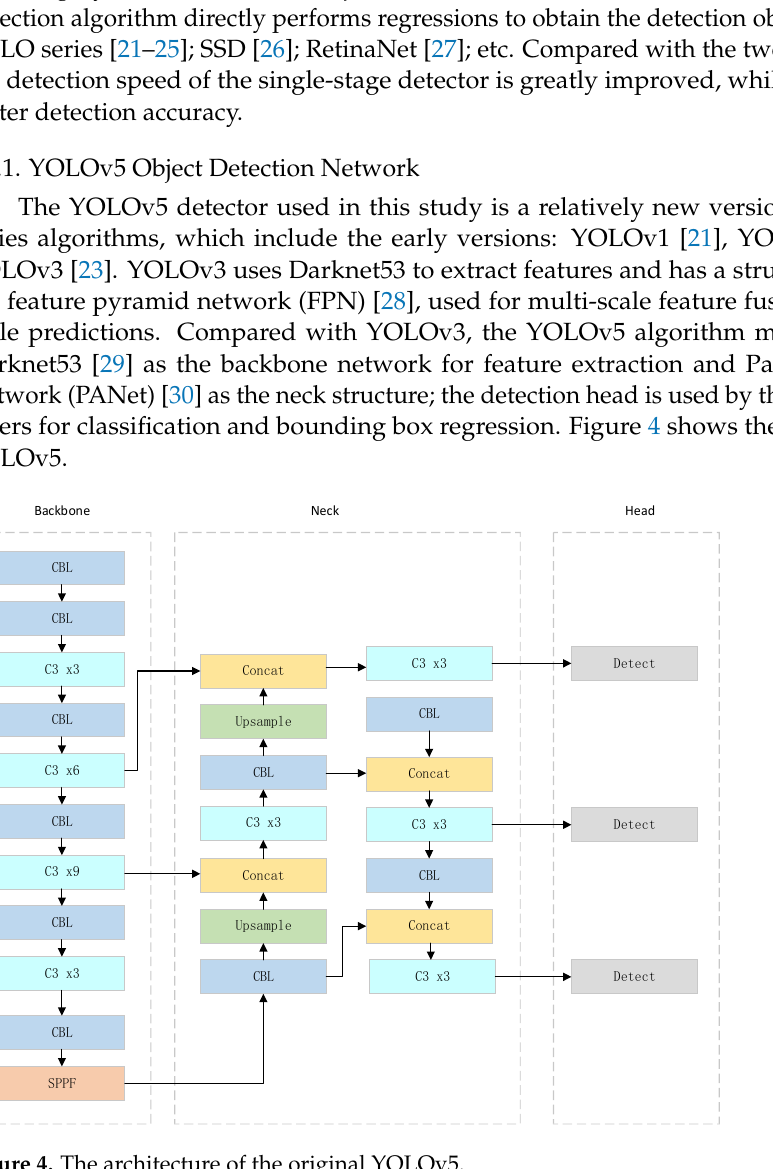
Figure 4. The architecture of the original